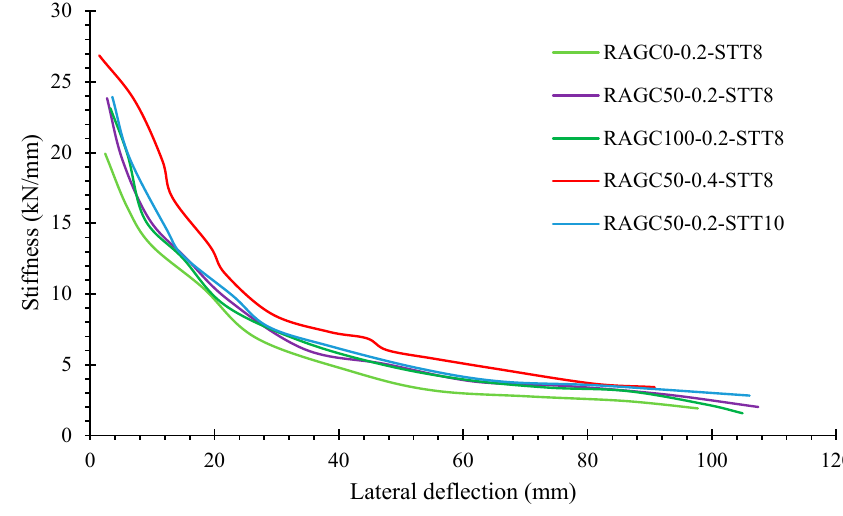
Figure 14. Degradation of stiffness of specimens.